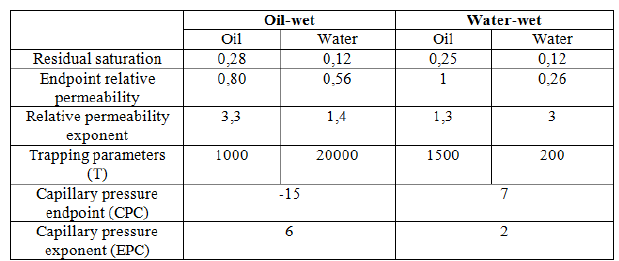
Table 1: Relative Permeability and Capillary Pressure Parameters (Low Trapping Number in Matrix)